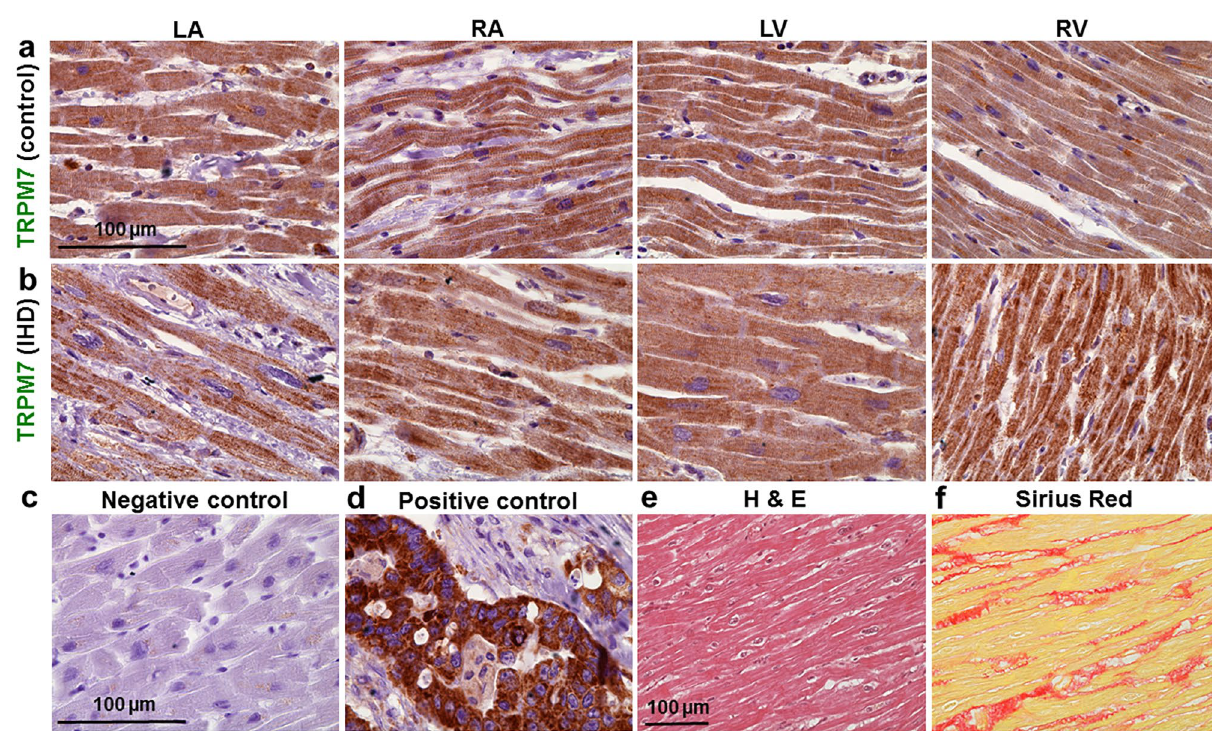
Figure 7. Representative histotopograms of TRPM7 images in the four chamber walls of the human heart. ( a ) Control subject after traffic accident. ( b ) IHD patient. The intensity of the brownish pigments shows areas with expression of TRPM7 in the heart (× 40 magnification). ( c ) Negative control in the LV. ( d ) Positive control of TRPM7 in tumour of the colon ( a–d , × 40 magnification). Note: for negative control an irrelevant IgG of the same isotope as the primary antibody was used. ( e , f ) Representative images of the regional assessment (from the LV midmyocardial tissue sections) of myocardial hypertrophy/degeneration and fibrosis using hematoxylin and eosin (H & E) staining and picrosirius red staining, respectively (× 20 magnification). Scale bars indicate 100